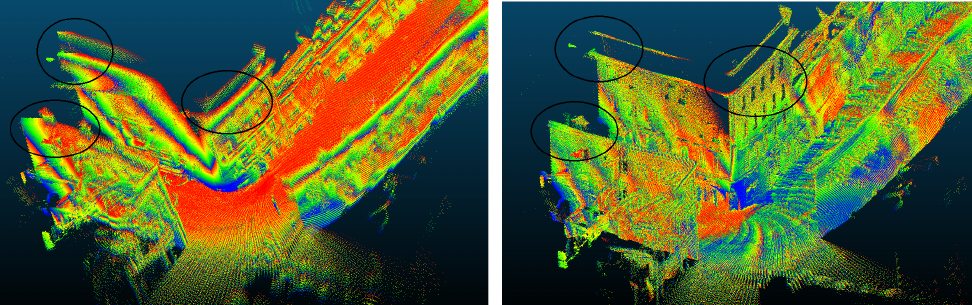
Figure 12: Real point cloud #4: left, before optimization of the parameters; right, after optimization. The two images have the same point of view.